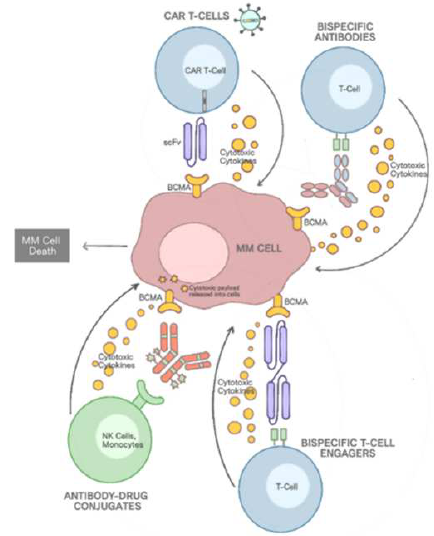
Figure 1. Anti-BCMA-therapy mechanism for multiple myeloma.